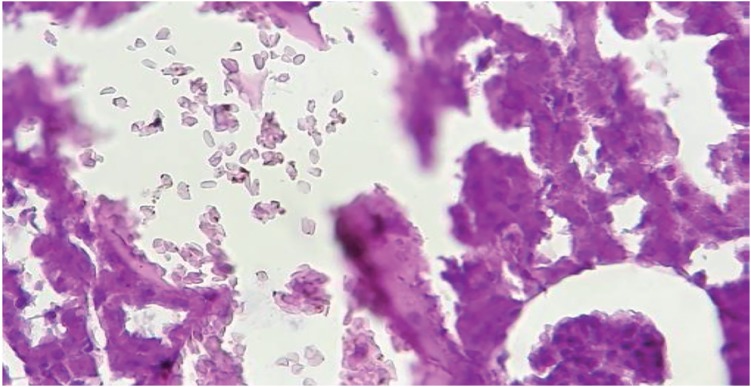
Accumulation of calcium oxalate crystals in kidney tubules in the negative group.